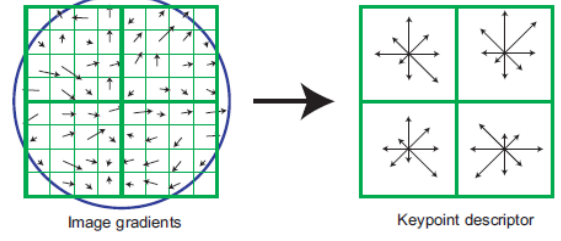
Fig. 2. Extrema of the difference-of-Gaussian